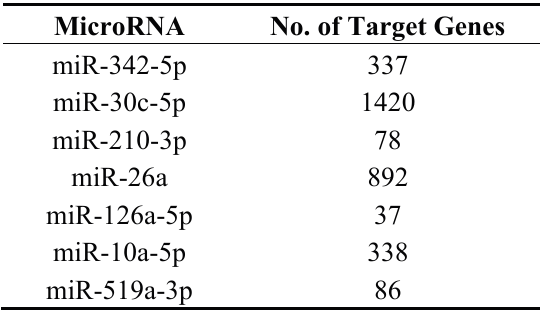
Table 2. Number of experimentally observed and highly predicted gene targets for the candidate microRNAs listed in Table